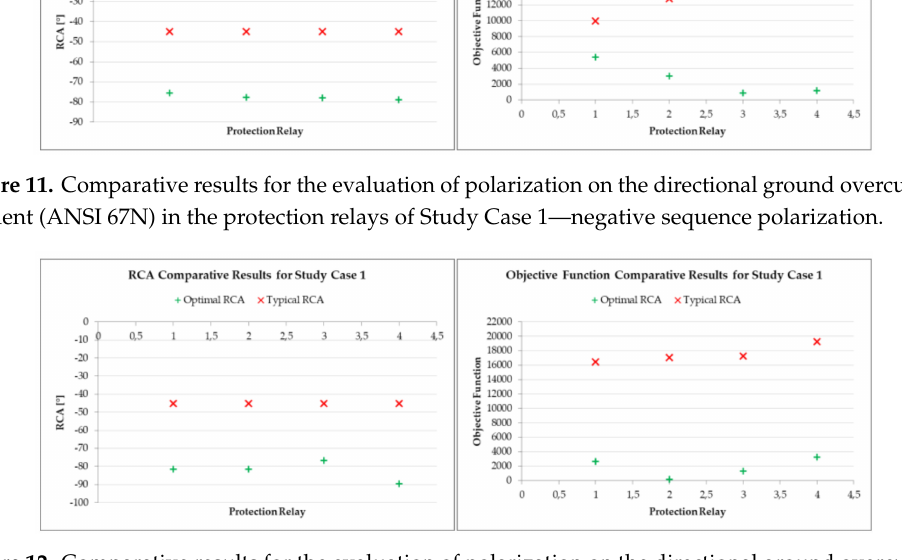
Figure 12. Comparative results for the evaluation of polarization on the directional ground overcurrent element (ANSI 67N) in the protection relays of Study Case 1—zero sequence polarization.